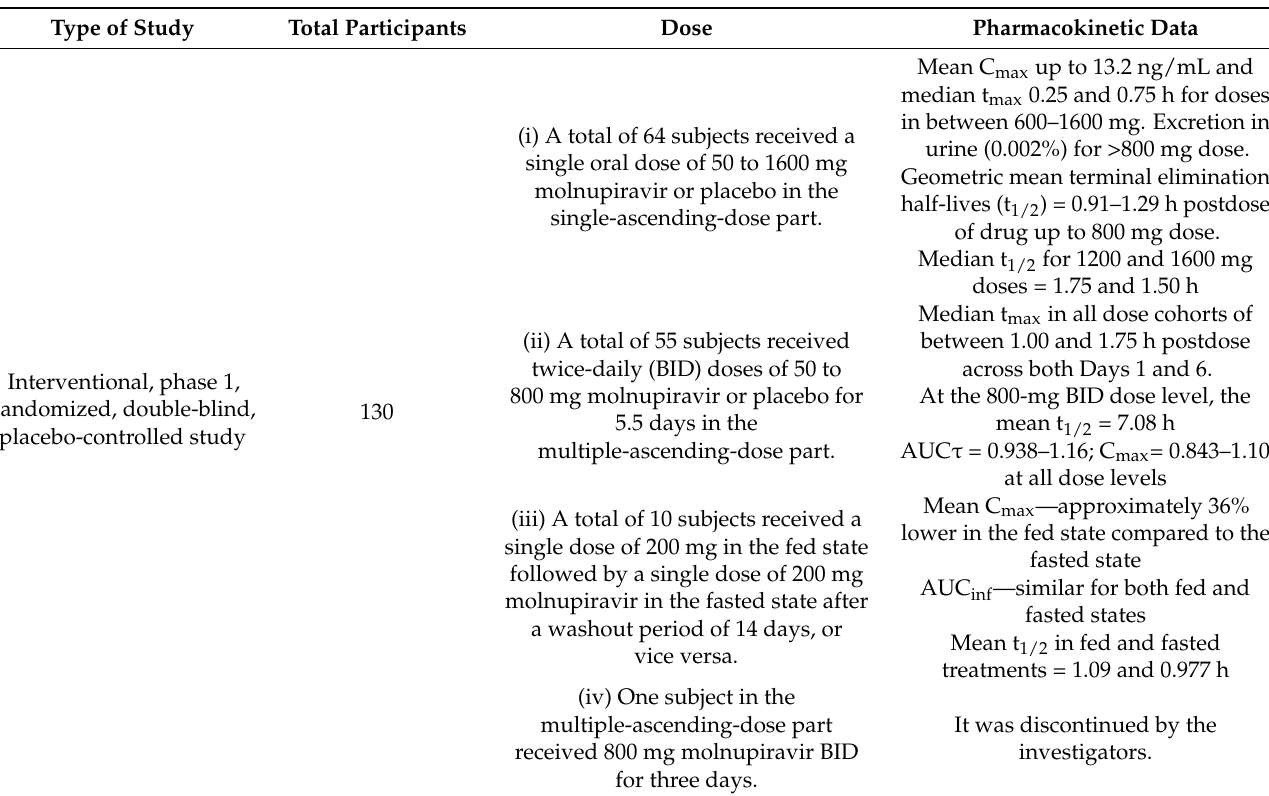
Table 2. Summary of the phase 1 clinical trials of